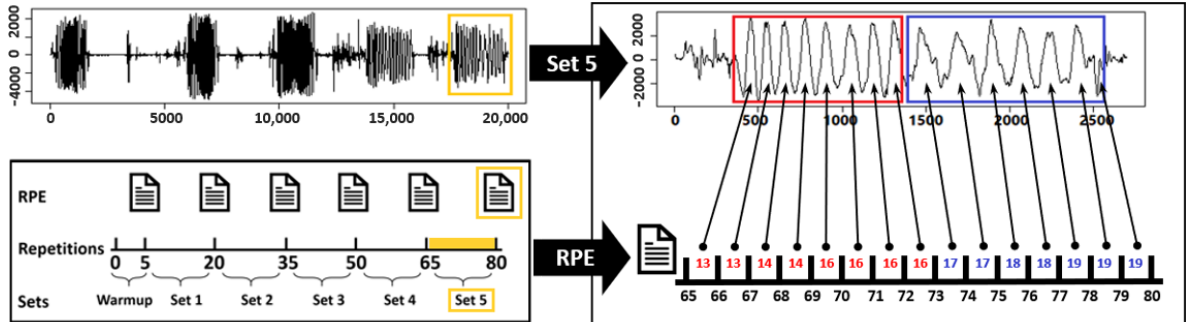
Figure 2. Extracting and labeling bicep concentration curl repetitions from the fifth